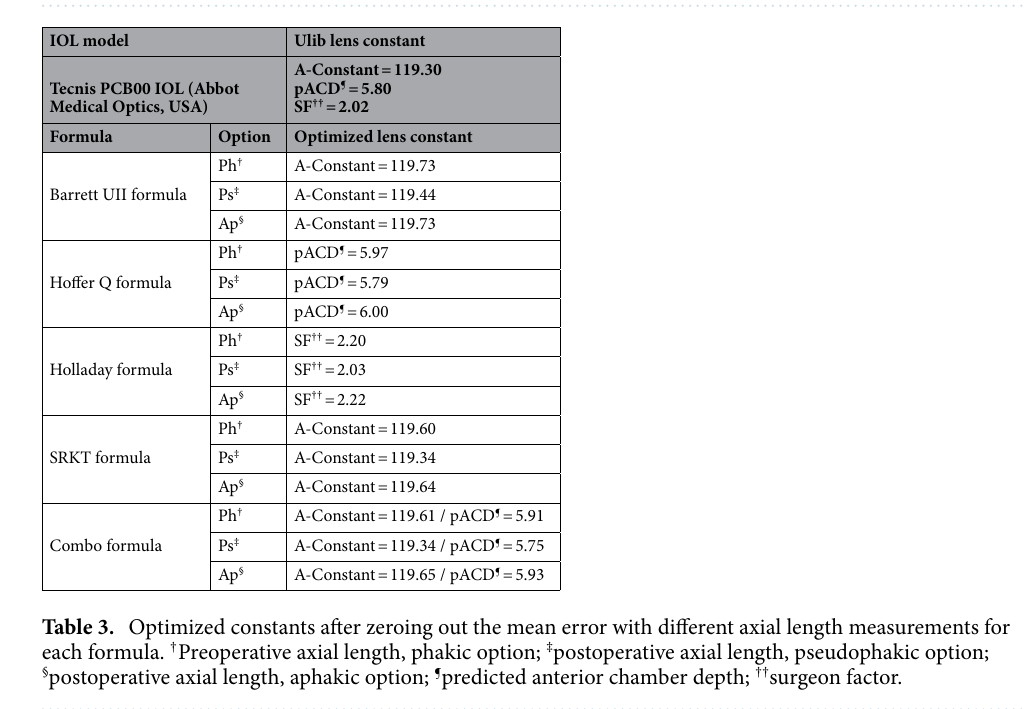
Figure 3. IOL power calculation formulas evaluation by utilizing phakic-option (Ph), aphakic-option (Ap) and pseudophakic-option (Ps).